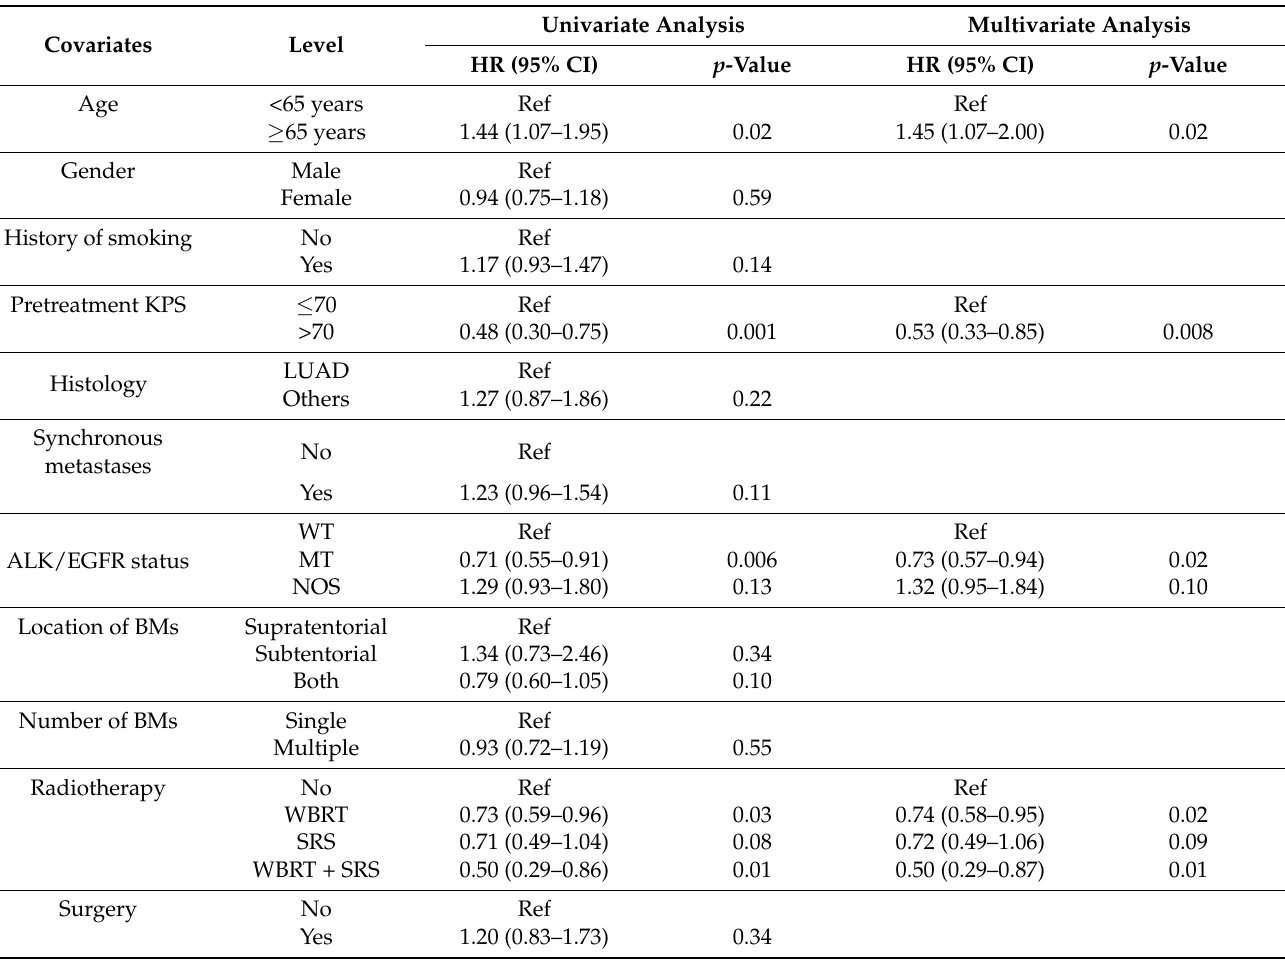
Table 4. Univariate and multivariate analyses of risk factors for OS in lung BMs patients with extracranial